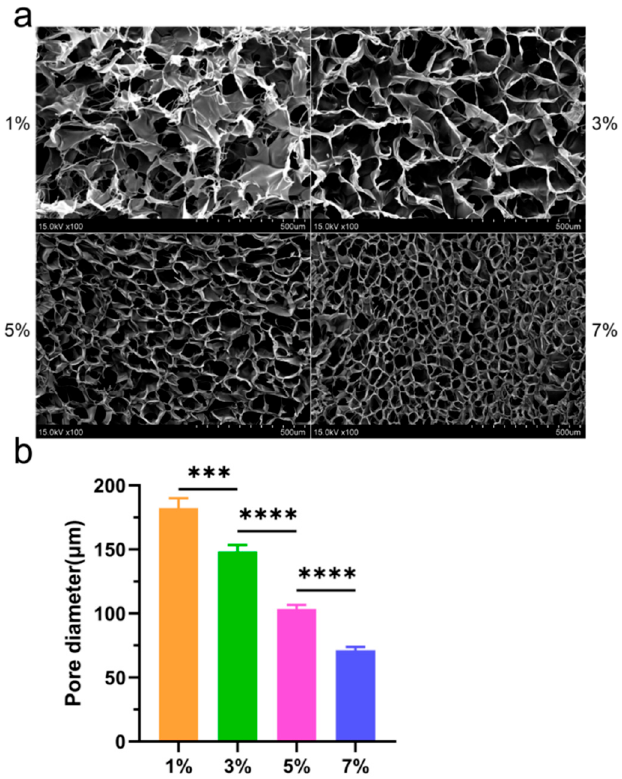
Figure 4. Cross-sectional SEM ( a ) and pore size statistics ( b ) of freeze-dried chitosan scaffolds at different concentrations, n = 30, *** p < 0.001, **** p < 0.0001.